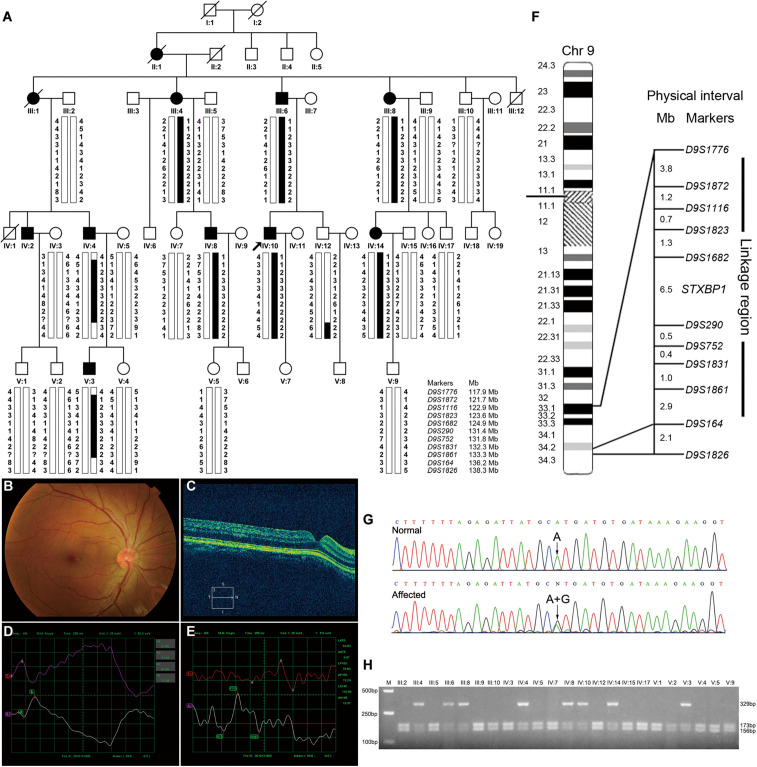
Pedigree structure, clinical characteristics of the index case, genotypic analysis, diagram of chromosome 9, identification of STXBP1 variant and RFLP analysis of the AD-CN family. (A) The pedigree structure and microsatellite haplotype analysis of the Chinese family with AD-CN. Individuals with CN are indicated by solid squares (males) or solid circles (females). Unaffected individuals are indicated by open symbols. Deceased individuals are indicated by slashes (/). The proband is indicated by an arrow. The disease haplotype is shown in black vertical bar; the variants of eight microsatellite markers (D9S1872, D9S1116, D9S1823, D9S1862, D9S290, D9S752, D9S1831, and D9S1861) are co-segregated with the clinical manifestation in the family. (B,C) Normal fundus (B) and normal foveal (C) of the proband. (D) The flash electroretinogram (fERG) of the proband. Both eyes show shortened latency and decreased amplitude of b-wave. The b-wave latency of right eye and left eye are 18.5 ms and 41.0 ms, respectively. The amplitudes of b-wave of right eye and left eye are 52.25 μV and 71.29 μV, respectively. (E) The pattern visual evoked potential (PVEP) of the proband. The amplitude of P100 wave in both eyes was decreased. The right eye shows a delayed latency of P100 wave, while the left eye shows a shortened latency of P100 wave. The amplitudes of P100 wave of right eye and left eye are 7.71 μV and 13.24 μV, respectively. The latency of P100 wave of right eye and left eye are 154 ms and 78.5 ms, respectively. (F) The linkage interval and flanking microsatellite markers are indicated. (G) DNA sequencing chromatograms show the heterozygous variant in STXBP1 identified in this study. (H) The NsiI restriction analysis showing full segregation of the c.47A>G variant with the disease phenotype in the family.